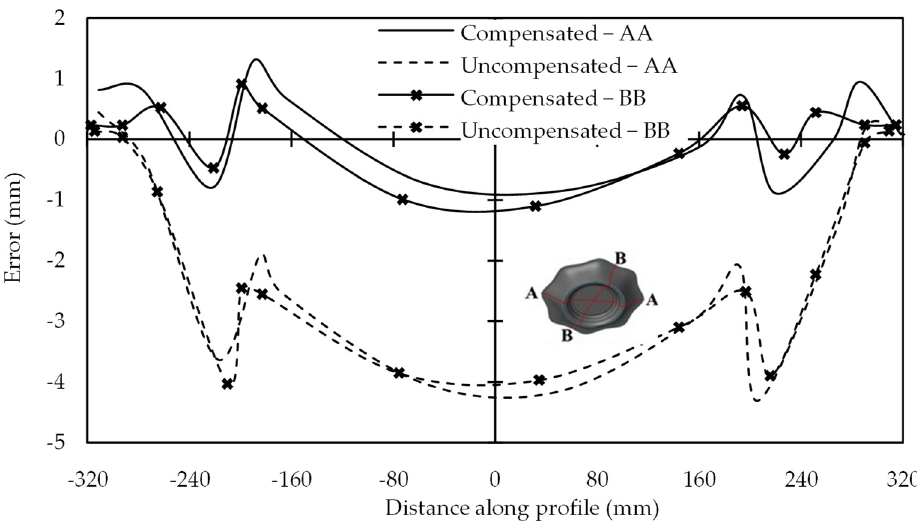
Figure 13. Error along section AA and BB for the feature of free-form geometry with 610 mm opening (reprinted with permission from Praveen et al. [52], Copyright 2020 Elsevier).